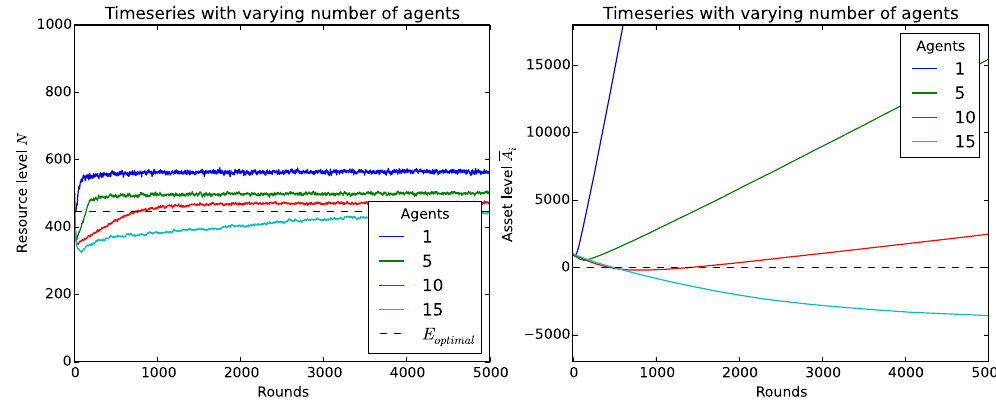
Figure 6. Time-series plots with varying number of agents and weight w = 0.5. Error bars have been omitted as the values are very small. The CPR game parameters are listed in Fig. 1. ( a ) The development of the resource level N over time with increasing number of agents. The black dotted line denotes the equilibrium E optimal derived in the analysis. ( b ) The development of the asset level A per agent with increasing number of agents. The black dotted line denotes the threshold for losses, i.e. A <